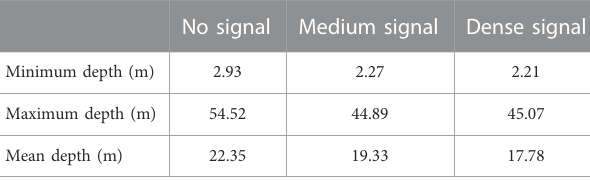
TABLE 1 Depth summaries of WCD signal strength (all substratum